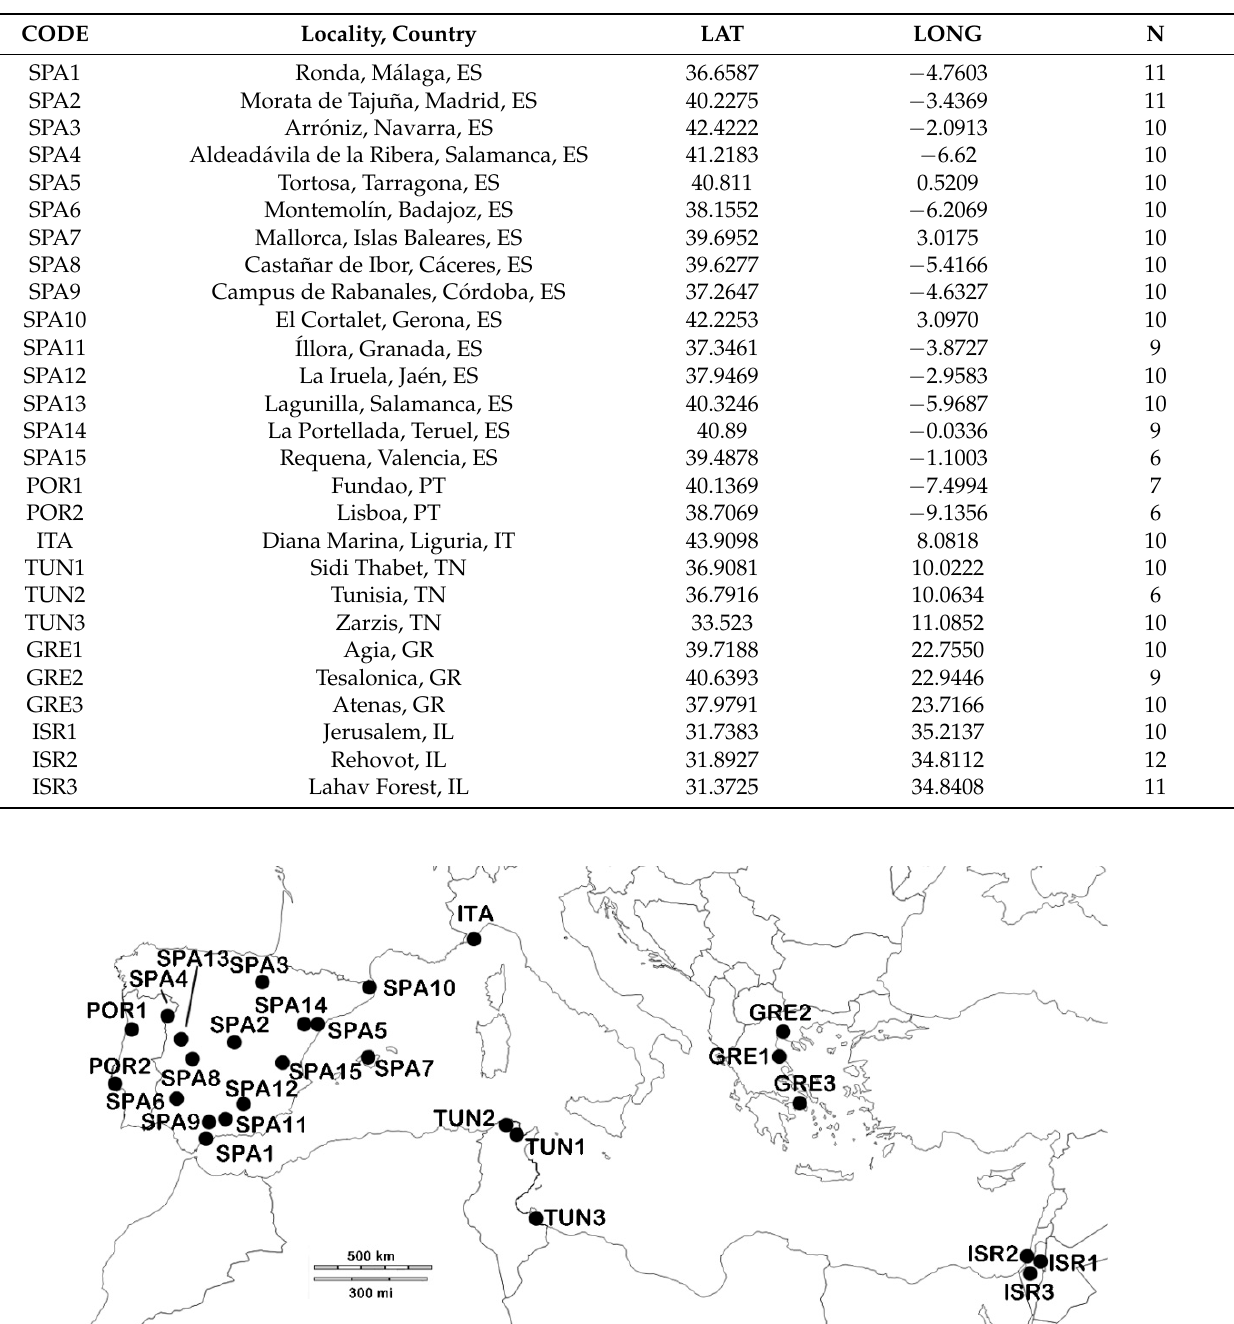
Table 1. Populations of B. oleae analysed with the code assigned, locality, geographical coordinates (LAT, latitude; LONG, longitude) and sample size (N). SPA, Spain; POR, Portugal; ITA, Italy; TUN, Tunisia; GRE, Greece; ISR, Israel.